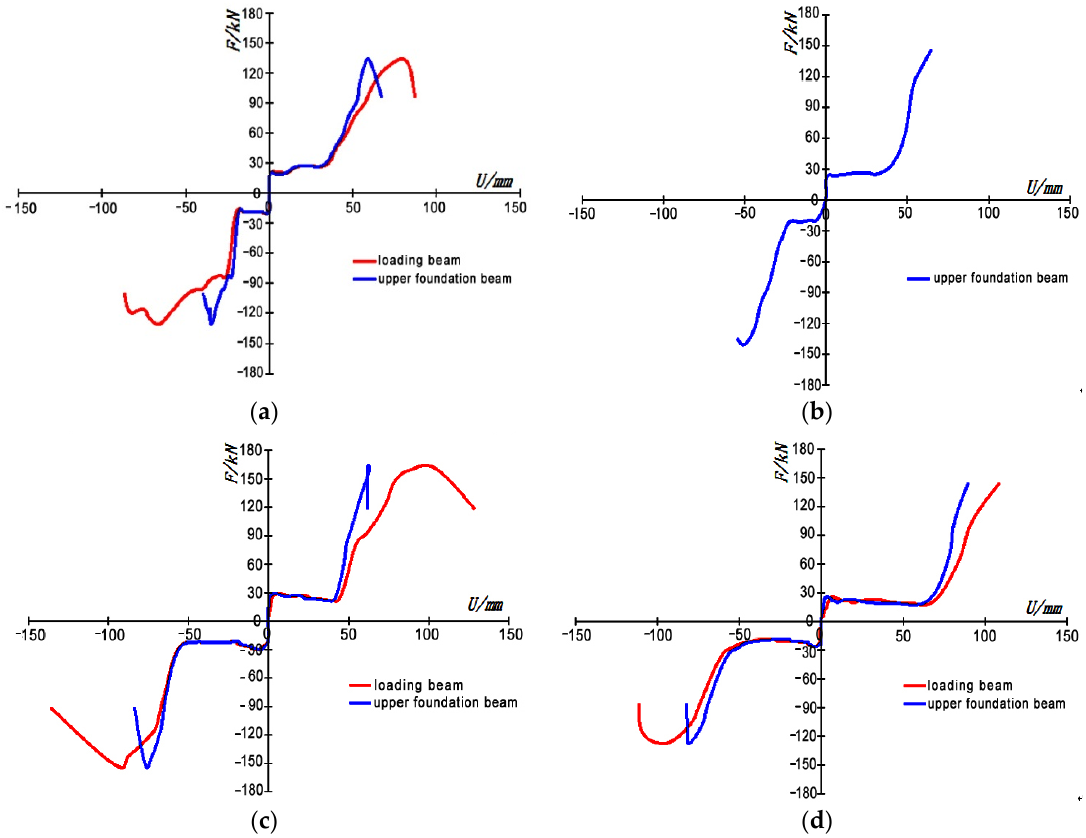
Figure 17. Comparison of F ‐ U 1 and F ‐ U 2 Skeleton Curves: ( a ) GGBW ‐ 1; ( b ) GGBW ‐ 2; ( c ) GGBW ‐ 3; ( d ) GGBW ‐ 4.